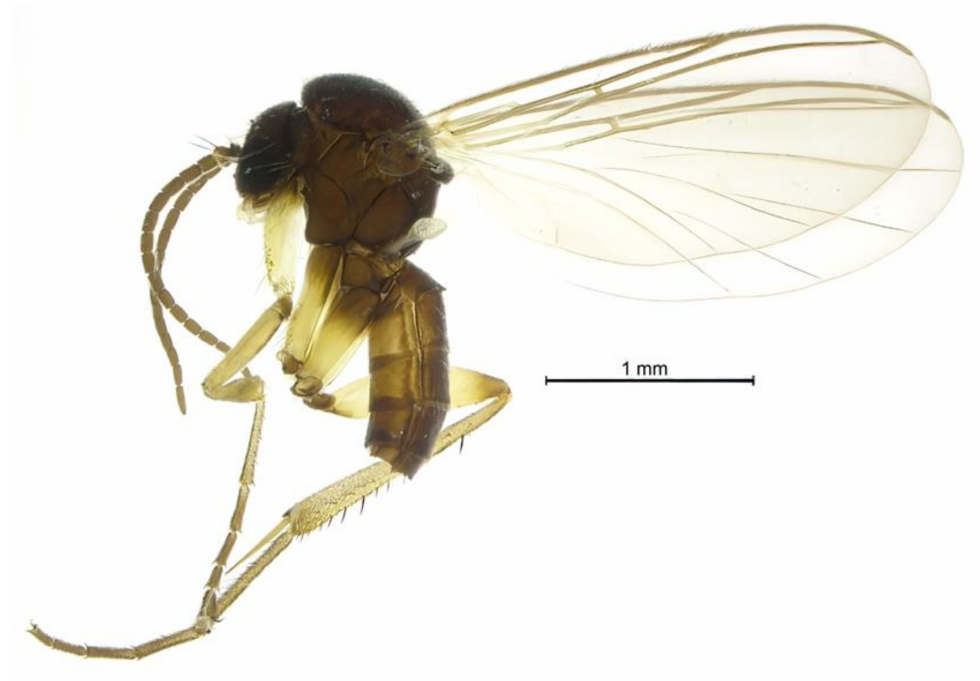
Figure 1. Docosia caucasica sp. n., (ZFMK-DIP-00082491), habitus, terminalia detached. ♂ Differential diagnosis. Based on the structure of the male terminalia, D. caucasica sp. n. belongs to a group of Palaearctic species that have posteroventral margin of the gonocoxites with (1) a prominent medial process of variable shape bearing dense aggregation of modi- fied setae, and (2) distinct lateral processes. In this group, the new species resembles D. landrocki Laštovka and Ševˇc í k, 2006 by having a similar outline of the medial process of the posteroventral margin of the gonocoxites and the gonostylus [8] (Figure 8), (Figure 3A–F). However, D. caucasica sp. n. has (1) the posterolateral process of the gonocoxites ventrally tapering, extending to the posterior third of the gonostylus (posterolaterally drawn out to small process that bears an aggregation of medially directed long setae and an apical spine-like prolongation in D. landrocki ), (2) dorsal lobe of the gonostylus posteromedially drawn out to a small extension (dorsal lobe of the gonostylus widening posteriorly, without an extension in D. landrocki ), (3) ventral lobe of the gonostylus with posterior prong bearing two clearly delimited, apically pointed subequal spines (posterior prong with apically spathulate and basally fused two long subequal spines in D. landrocki ), (4) ventral lobe of the gonostylus with anterior prong bearing an apical sabre-shaped spine (anterior prong apically bifid, with small spine apically on more posterior ramus in D. landrocki ), (5) param- eral apodeme in ventral view widened posteriorly (evenly rounded in D. landrocki ), and (6) aedeagus with well elongated hook-like apical part (aedeagus hooked, not elongated in D. landrocki